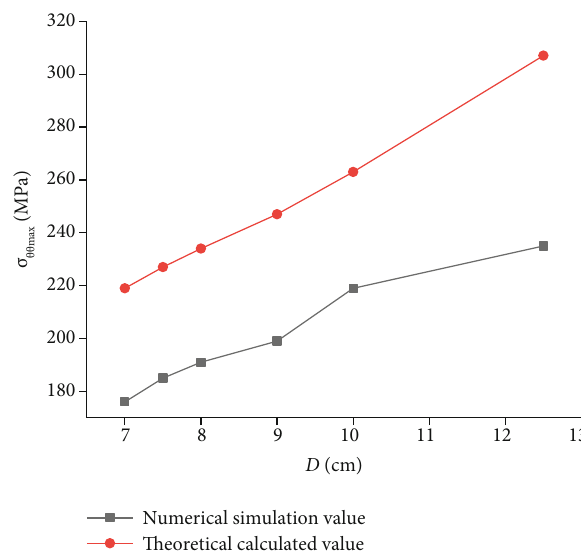
Figure 3: Comparison of maximum tensile stress between theoretical calculation and numerical